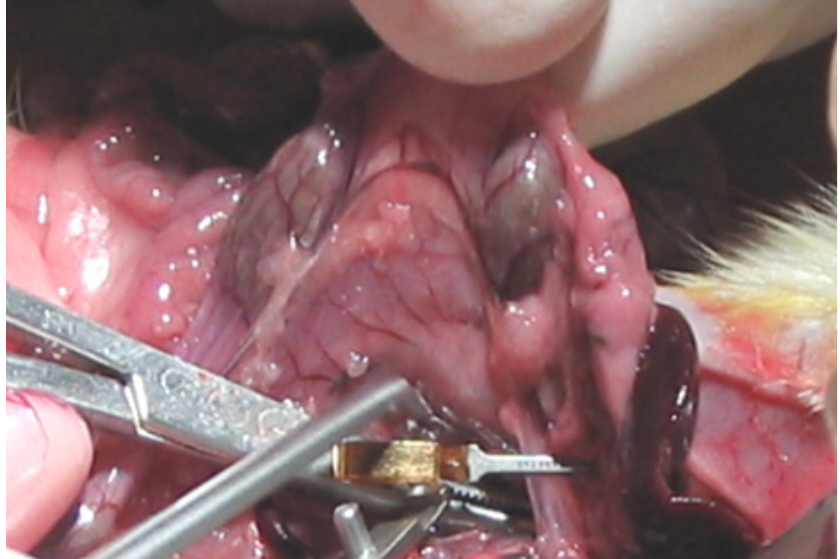
FIGURE 1 – Holding of the superior mesenteric artery